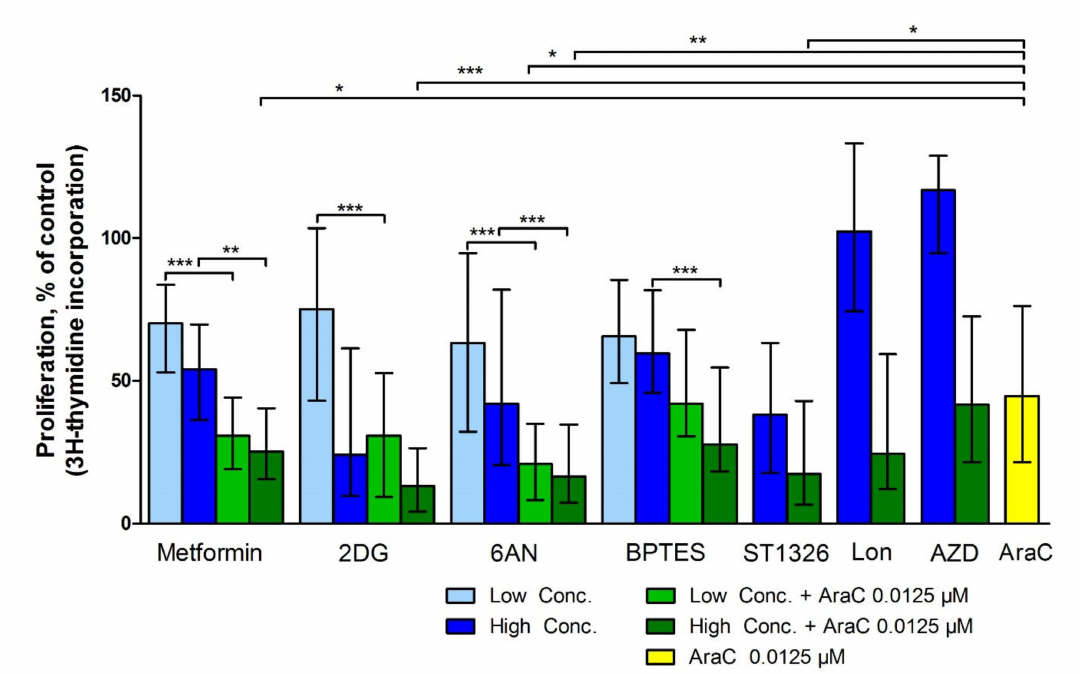
Figure 2. The effect of the combined treatment of metabolic inhibitors with AraC on AML cell proliferation, using the [ 3 H]-thymidine incorporation assay. The metabolic inhibitors were tested at the following concentrations—metformin 1.25 and 2.5 mM, 2-DG 0.3 and 0.6 mM, 6AN 50 and 100 µ M, BPTES 10 and 20 µ M, ST1326 50 µ M, lonidamine 300 µ M and AZD3965 200 nM alone and in combination with AraC 0.0125 µ M. All 69 patients with detectable proliferation in untreated control cultures were included in this analysis, except ST1326 which included 53 patients with detectable proliferation among 62 patients tested. The results are presented as the median percentage of proliferation in cell cultures treated with metabolic inhibitors alone or in combination with AraC compared to their corresponding control cultures, with interquartile range (whiskers). The Kruskal-Wallis test with Dunn’s post-hoc test was used for statistical comparisons between effects of metabolic inhibitors alone and metabolic inhibitors combined with AraC (significant p -values are shown right above each column) and between AraC alone versus combination treatment of AraC with metabolic inhibitors (illustrated at the top of the figure). * p -value < 0.05 and, ** p -value 0.001 and ***, p -value < 0.0001; Lon, Lonidamine; AZD,